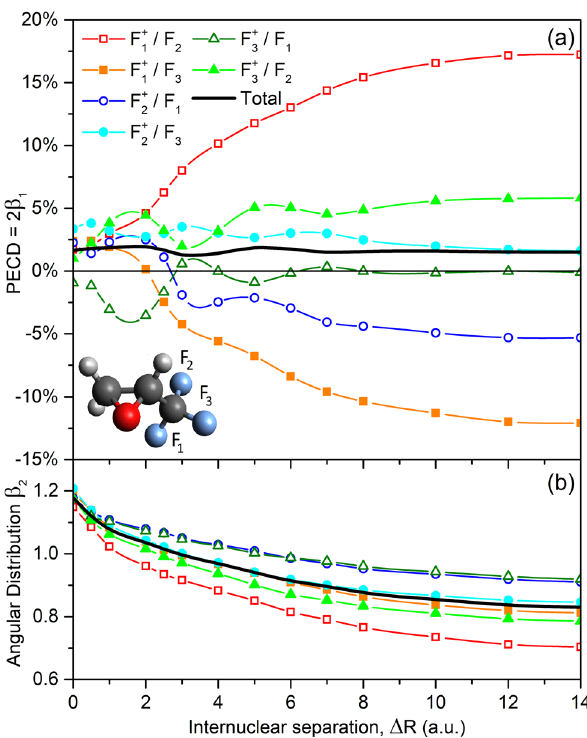
Fig. 2 Theoretical estimates for emission patterns. Panel ( a ) PECD and panel ( b ) angular distribution parameter of 1s photoelectrons of the individual fl uorine atoms F i (as enumerated in the inset-picture) remaining bound to the singly charged C 3 H 3 F 2 O + mother-fragment and the respective averaged quantities, computed for the R-tri fl uoromethyloxirane at different distances R C − F = R eq + Δ R between the C atom of the CF 2 -group and the fl uorine ions dissociating along the bond (see legend for individual F þ j